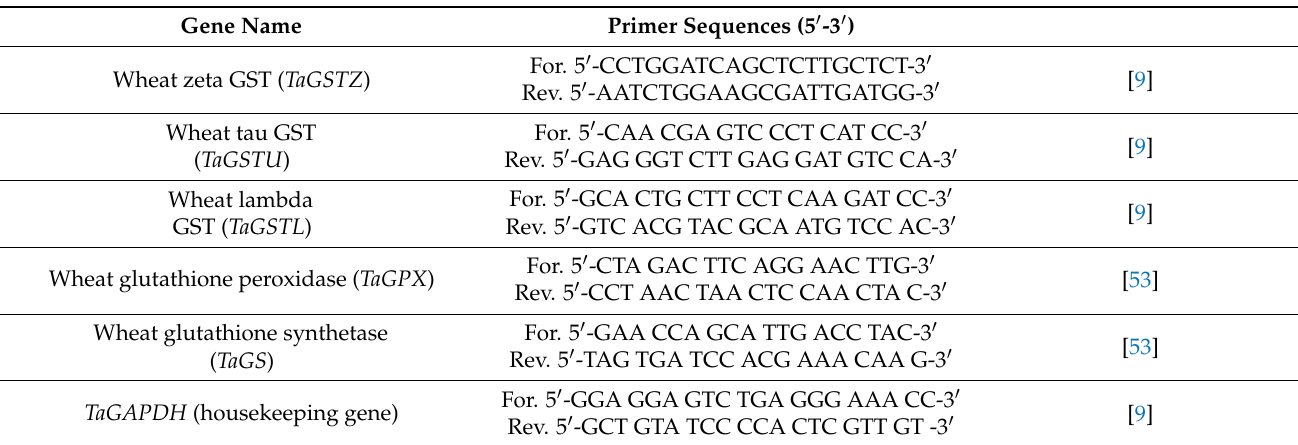
Table 3. Primer sequences of the studied